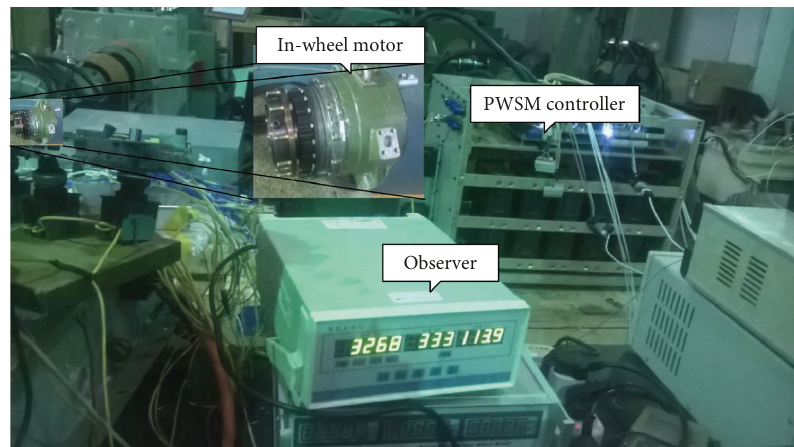
Figure 5: PMSM calibration and debugging diagram.